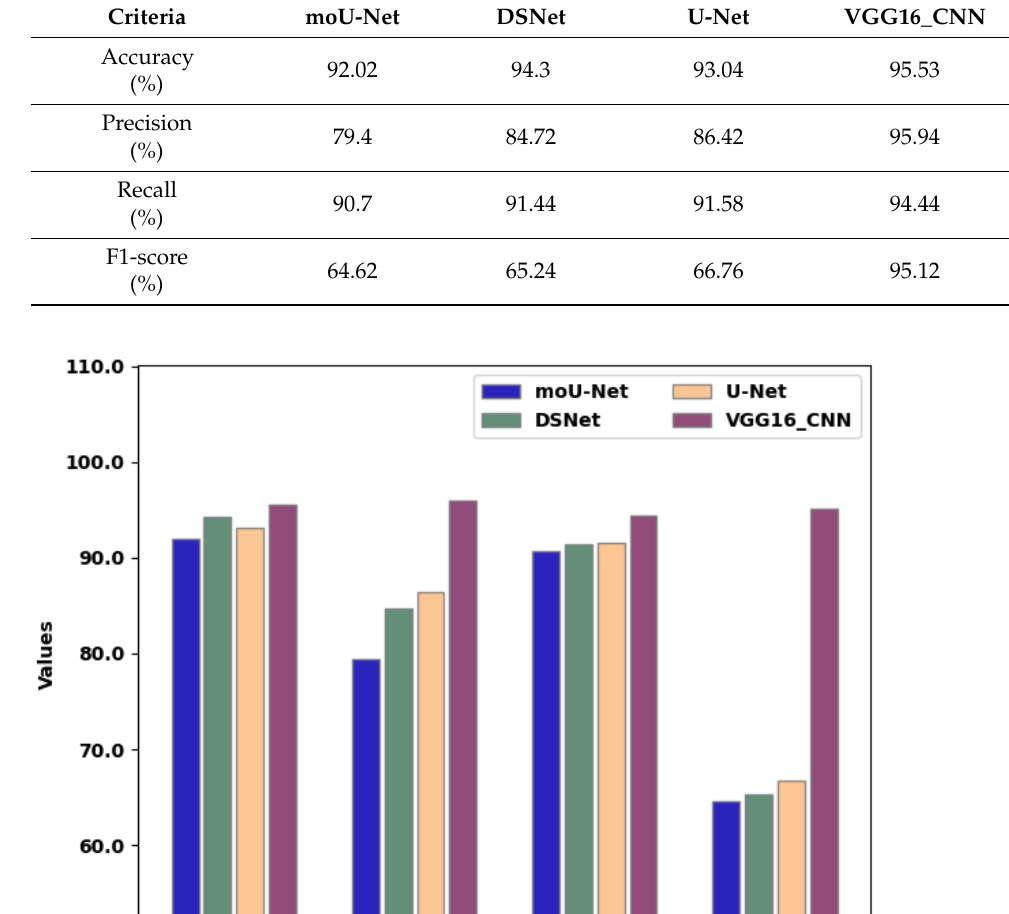
Table 6. Comprehensive comparison between proposed and existing methodologies.